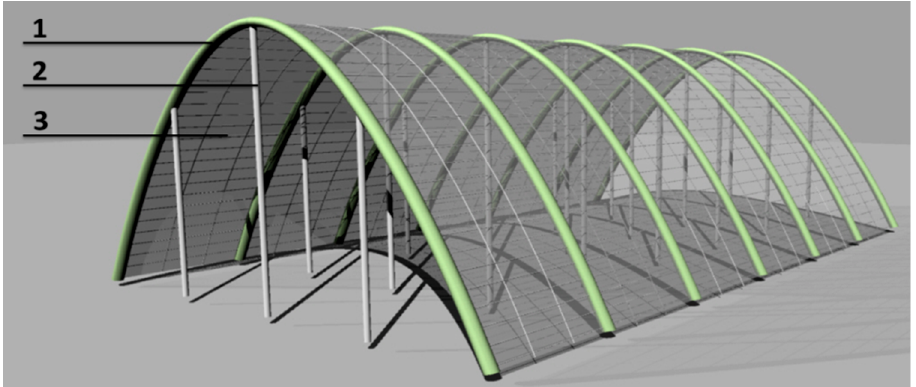
Figure 2. Perspective of arched date palm midribs bundle vault (Reproduced from [15]). (1) Arched date palm midribs bundles. (2) Date palm trunks as intermediate columns. (3) Date palm midribs bundles as purlins.